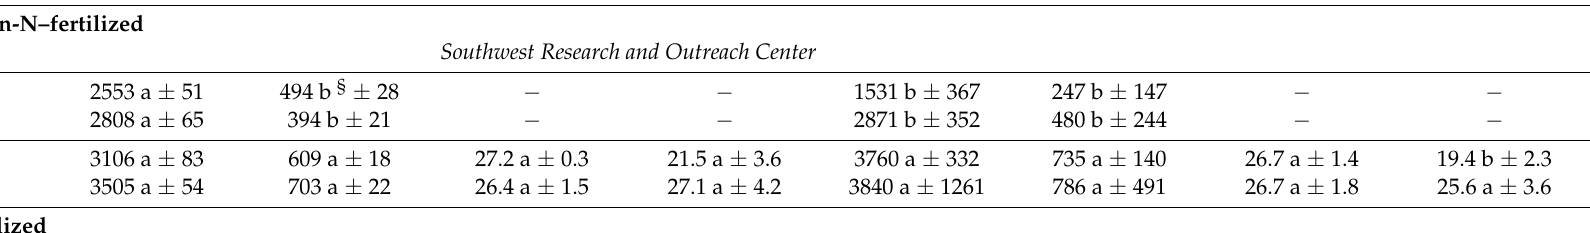
Table 3. Performance of winter camelina with and without N–fertilization double cropped with maize and soybean at two locations in Minnesota. Followed by Maize Followed by Soybean Grain Grain Cropping Biomass System ‡ Yield Oil Protein Yield Oil